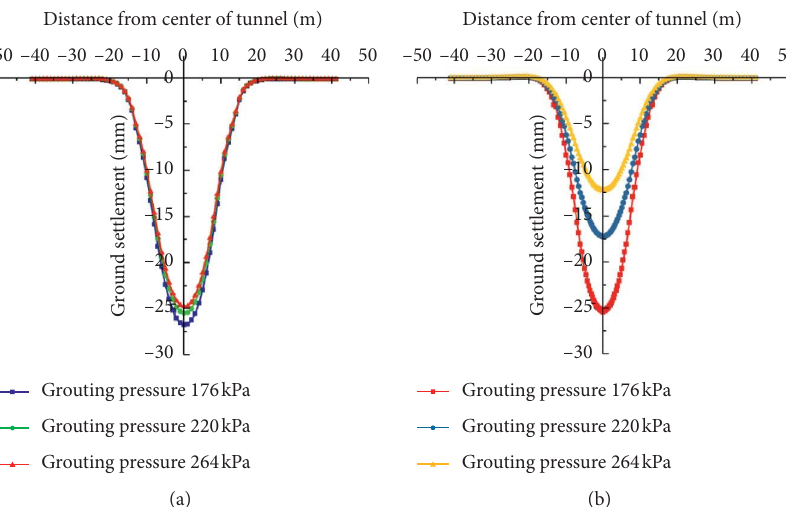
Figure 18: Ground surface settlement of shield and pipe jacking under different grouting pressures: (a) Ground surface settlement of shield. (b) Ground surface settlement of pipe